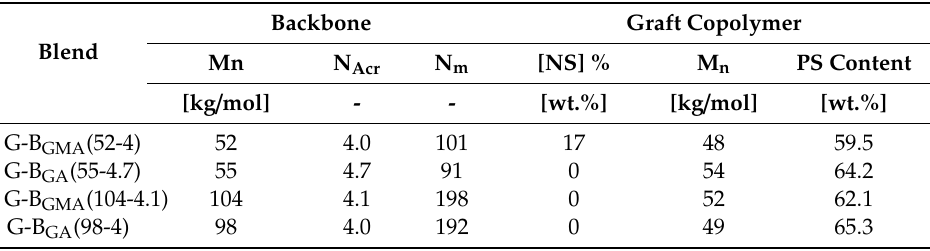
Table 4. Comparison of non-soluble fraction and molecular weight of copolymer blends based on GA and GMA backbones.